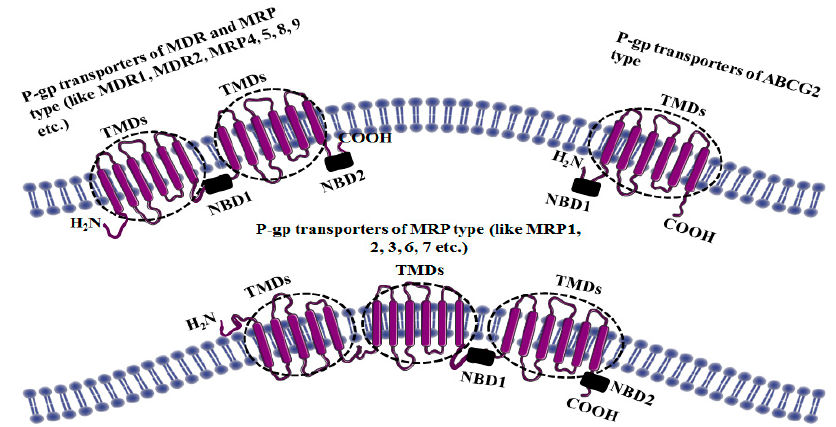
Figure 1. Basic structures of different types of P-gp transporters [2].